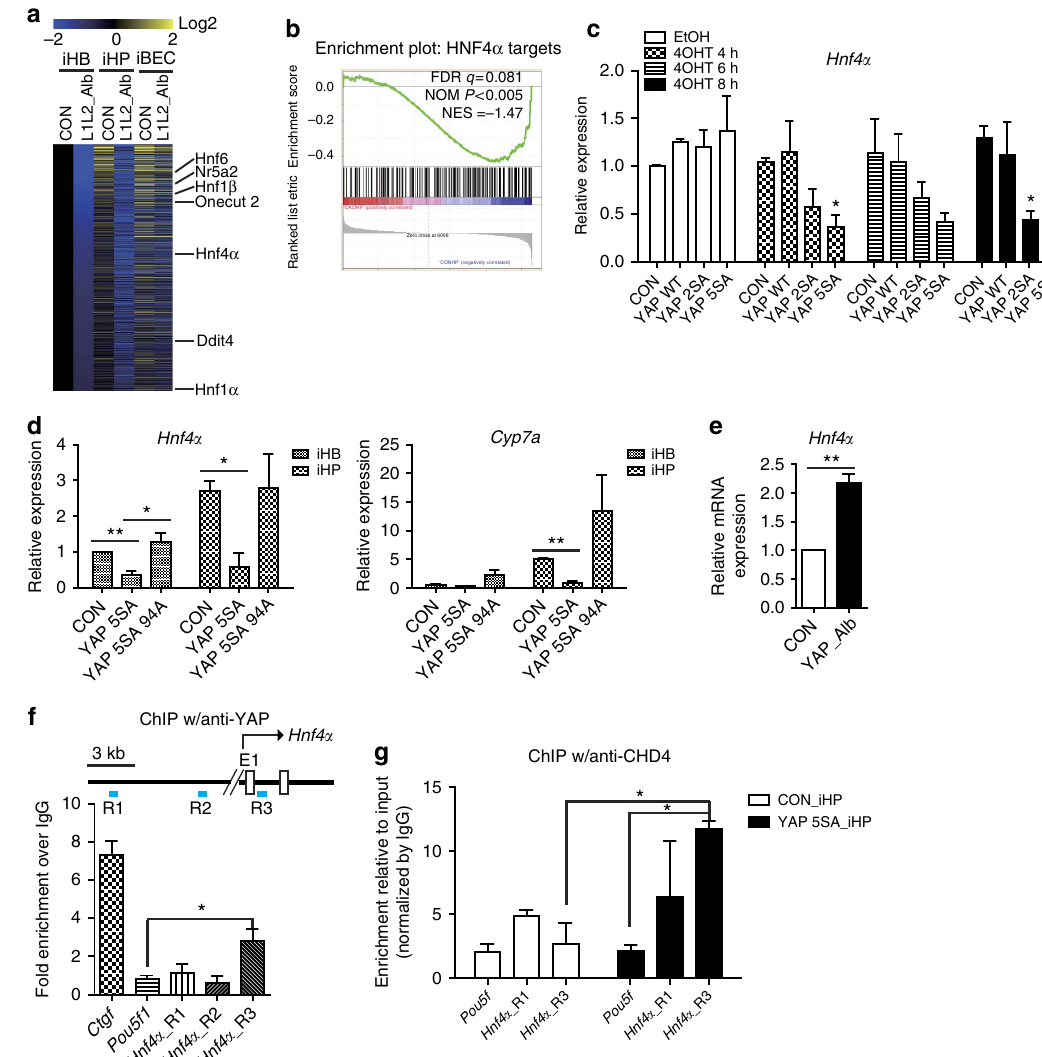
Figure 7 | YAP represses the hepatic transcription factor Hnf4 a , resulting in defective hepatocyte differentiation. ( a ) Heat map for genes found to be commonly down-regulated in Lats1/2 -deficient hepatoblasts, differentiated hepatocytes and BECs. ( b ) Hnf4 a target gene signature plot between control and Lats1/2 -deficient iHPs. ( c ) Relative mRNA expression levels of Hnf4 a in Aml12 cell lines stably expressing oestrogen receptor fused Yap mutants; control, YAP WT, -2SA and -5SA-ER T2 following their induction by tamoxifen for the indicated times. n ¼ 2. ( d ) Relative mRNA expression levels of Hnf4 a and Cyp7a1 in YAP 5SA and YAP 5SA 94A (Tead-binding defective) over-expressing iHBs and iHPs. ( e ) Relative mRNA expression levels of Hnf4 a in control and Yap-knockout iHPs. ( f , g ) chromatin immunoprecipitation (ChIP) analysis of the Hnf4 a locus in flag- YAP 5SA over-expressing iHPs, performed using anti-flag or -YAP ( f ) and anti-CHD4 ( g ). The data are presented as means ± s.e.m.; n ¼ 3, * P o 0.05 (Student’s t